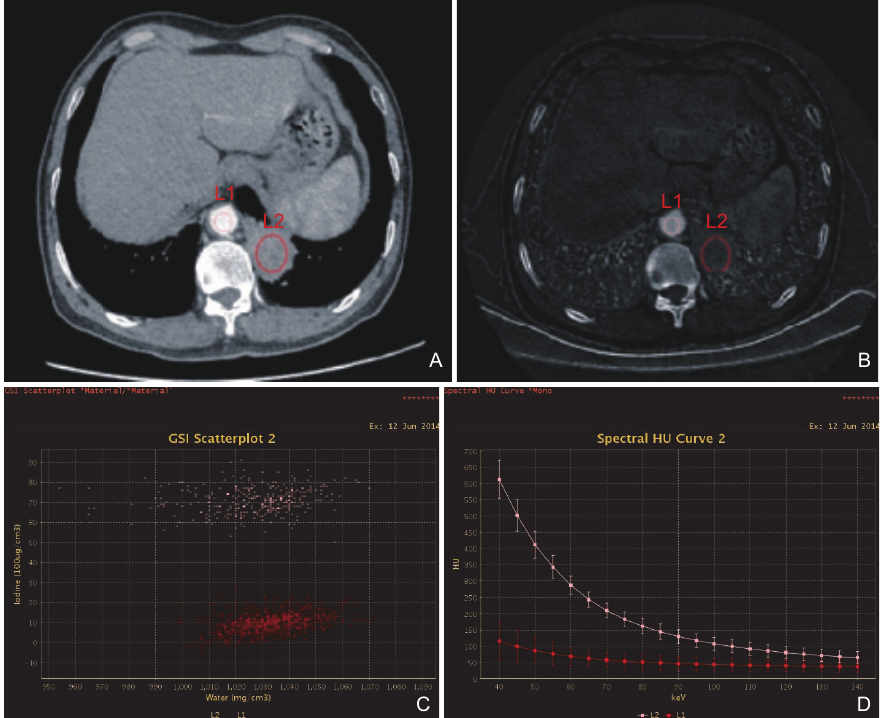
Figure 2 Axial monochromatic CT image (A) and iodine-based material decomposition image (B) of a 62-year-old man diagnosed with central SqCC measuring 4.5 cm in the left lower lobe of the lung. L1 and L2 represented the measurements of iodine concentration of tumor (maximun ICles= 43 mg/ mL) and descending aorta (maximun IC ao = 116 mg/mL). NIC max then was calculated as 0.37 for this lesion.